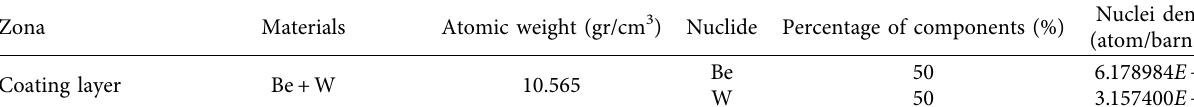
Table 1: Atomic densities of blanket material in each zone.